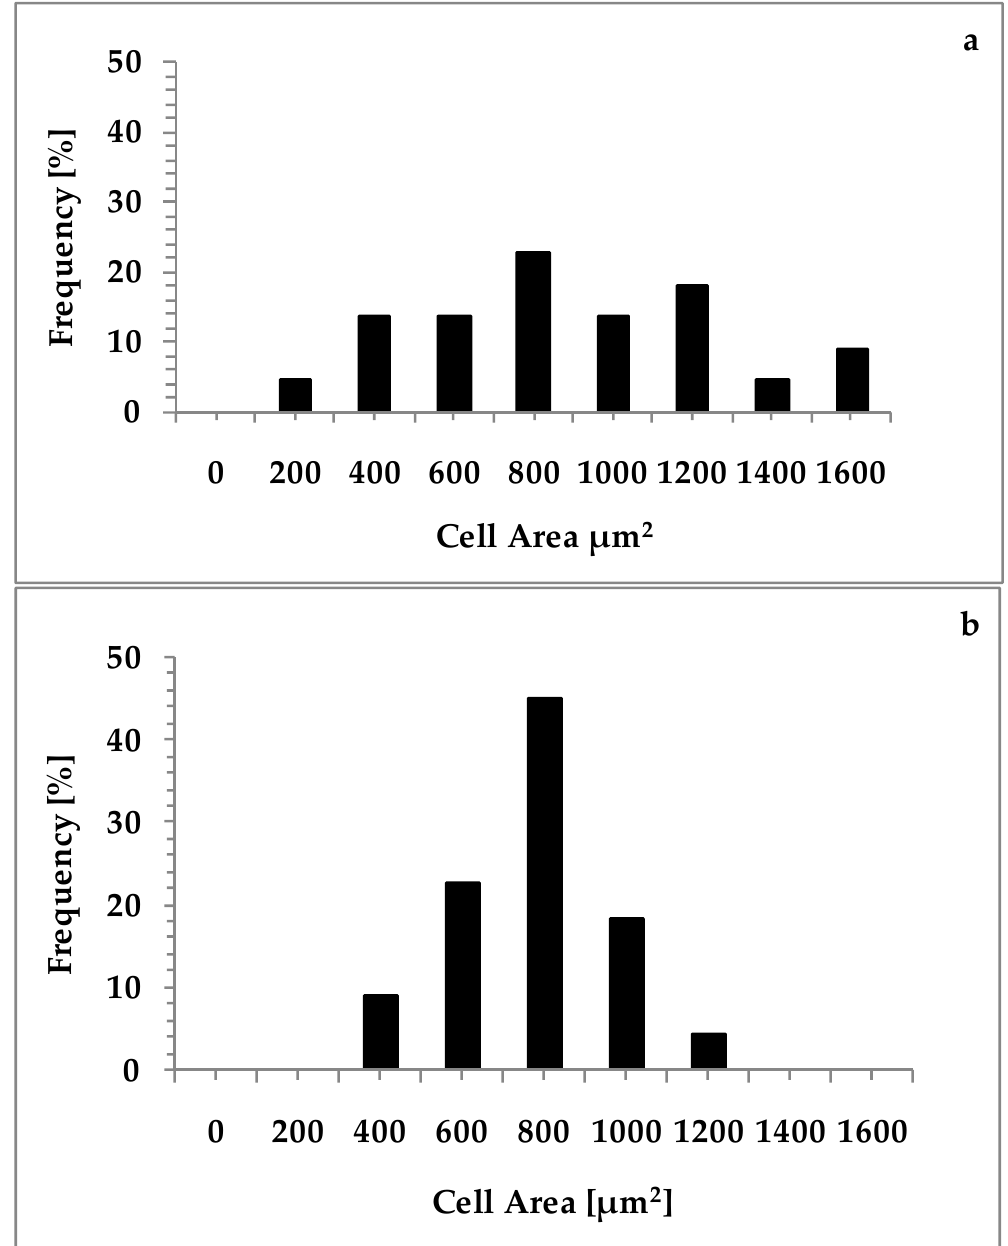
Figure 2. Histogram showing the relative frequency of individual subclasses of porcine skin-projecting SChG neurons, defined by their cross-sectional area in: lumbar ( a ); and sacral ( b ) SChGs ( n = 200 neurons were measured for each histogram).